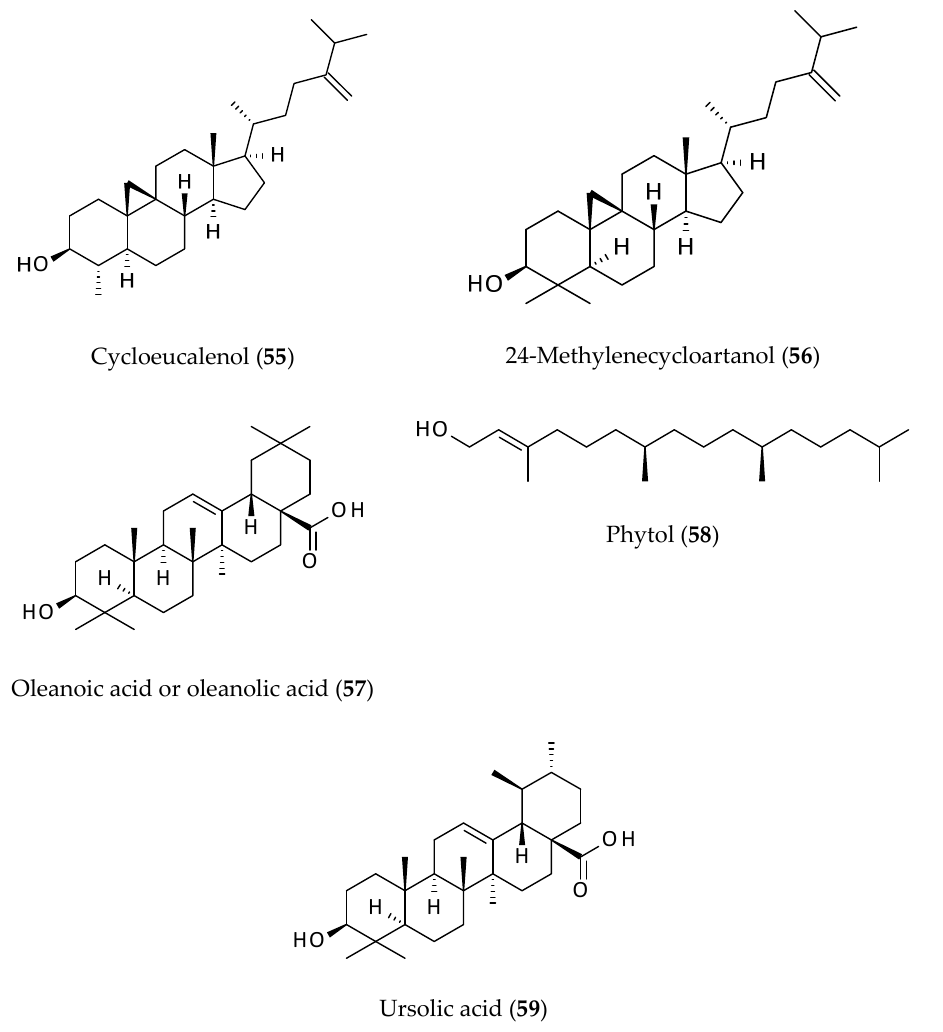
Figure 9. Terpenoids from Alternanthera philoxeroides . Triterpenes form a large class of natural products, ca. 20,000 discovered to date, with significant differences in structural features and functional groups, and their binding to biomolecules varies considerably. One of the major bioactivities of certain triterpenes is their antiviral property, which are mediated through their interactions with various mac- romolecules. For example, triterpenes have been shown to manipulate several virus–host fusions by wrapping the heptad repeat-2 (HR2) domain, which are generally found in viral envelops [65], and to inhibit the entry of several viruses (e.g., Ebola, Marbug, human immunodeficiency virus (HIV), and influenza A). Natural triterpenes, particularly cy- cloartane and oleane classes, were shown to exert their anti-inflammatory, chemopreven-